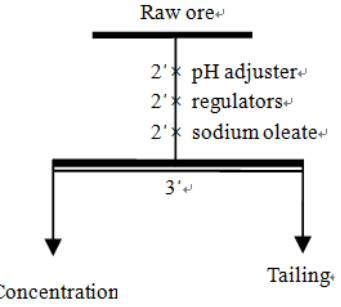
Figure 3. Flowchart of flotation test.